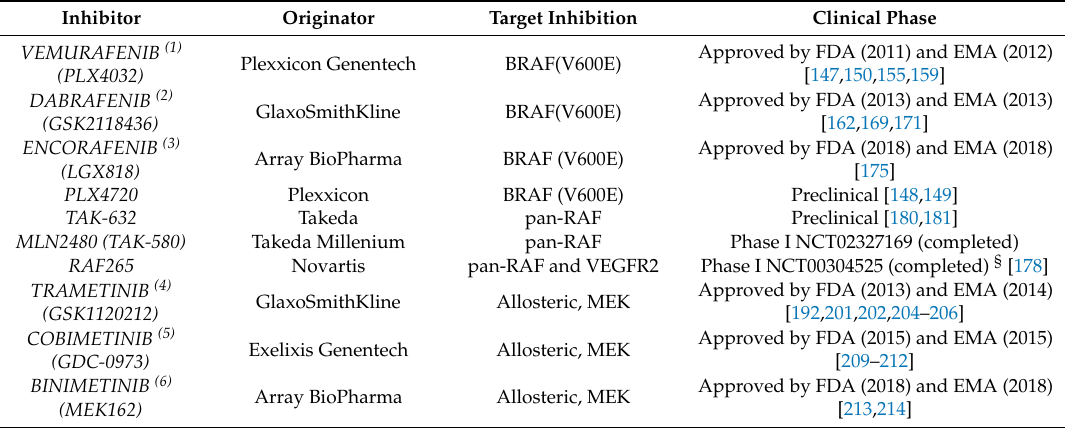
Table 2. RAF/MEK/ERK inhibitor developed for melanoma